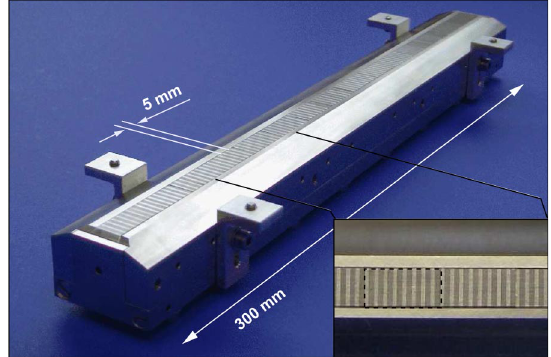
3. (Color) Photograph of the lower half of the 60 period planar undulator after the first preliminary assembly. In the inset, the precision glued magnet stacks are visible (dashed box).